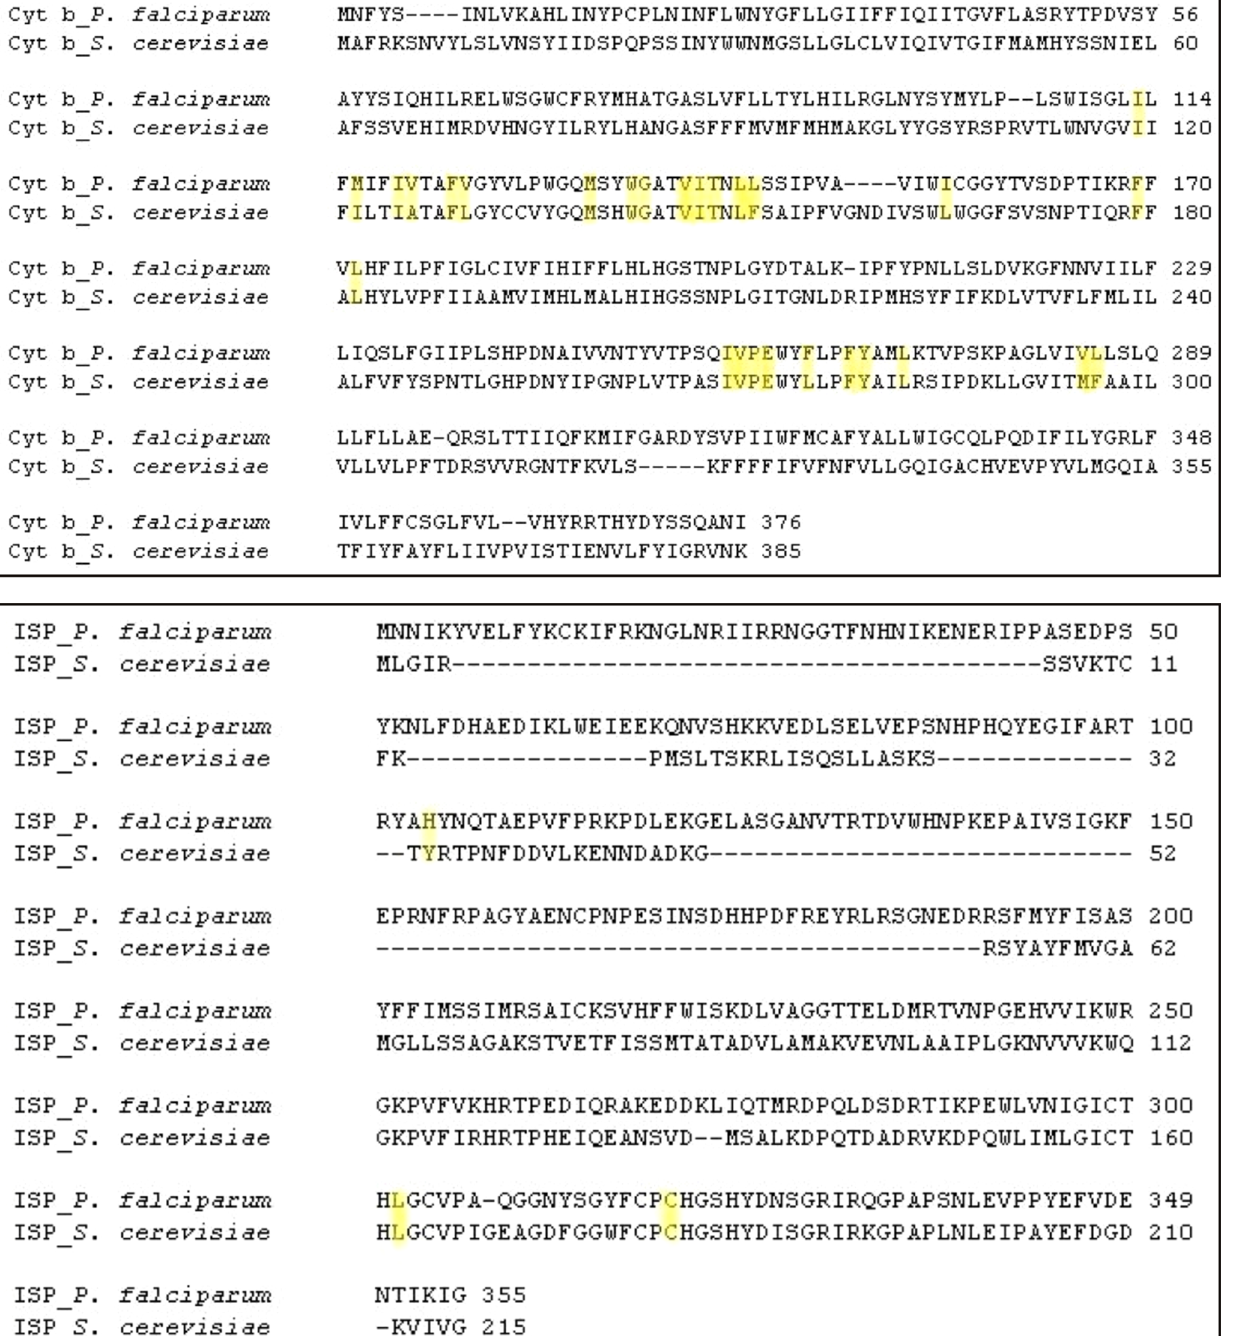
Figure 1. Sequence alignment of Cyt b protein and ISP chain of P.falciparum and S.cerevisiae . Amino acid residues involved in the formation of Qo site are highlighted in yellow tinted color. discovery of binary interactions. The Qo site residues were chosen to define the binding site in our modeled Cyt bc1 complex of P. falciparum based on known Qo site inhibitor interactions for S. cerevisiae available in protein data bank (pdb id: 3CX5, 2IBZ). A total of 10 random ligand conformations were generated from the